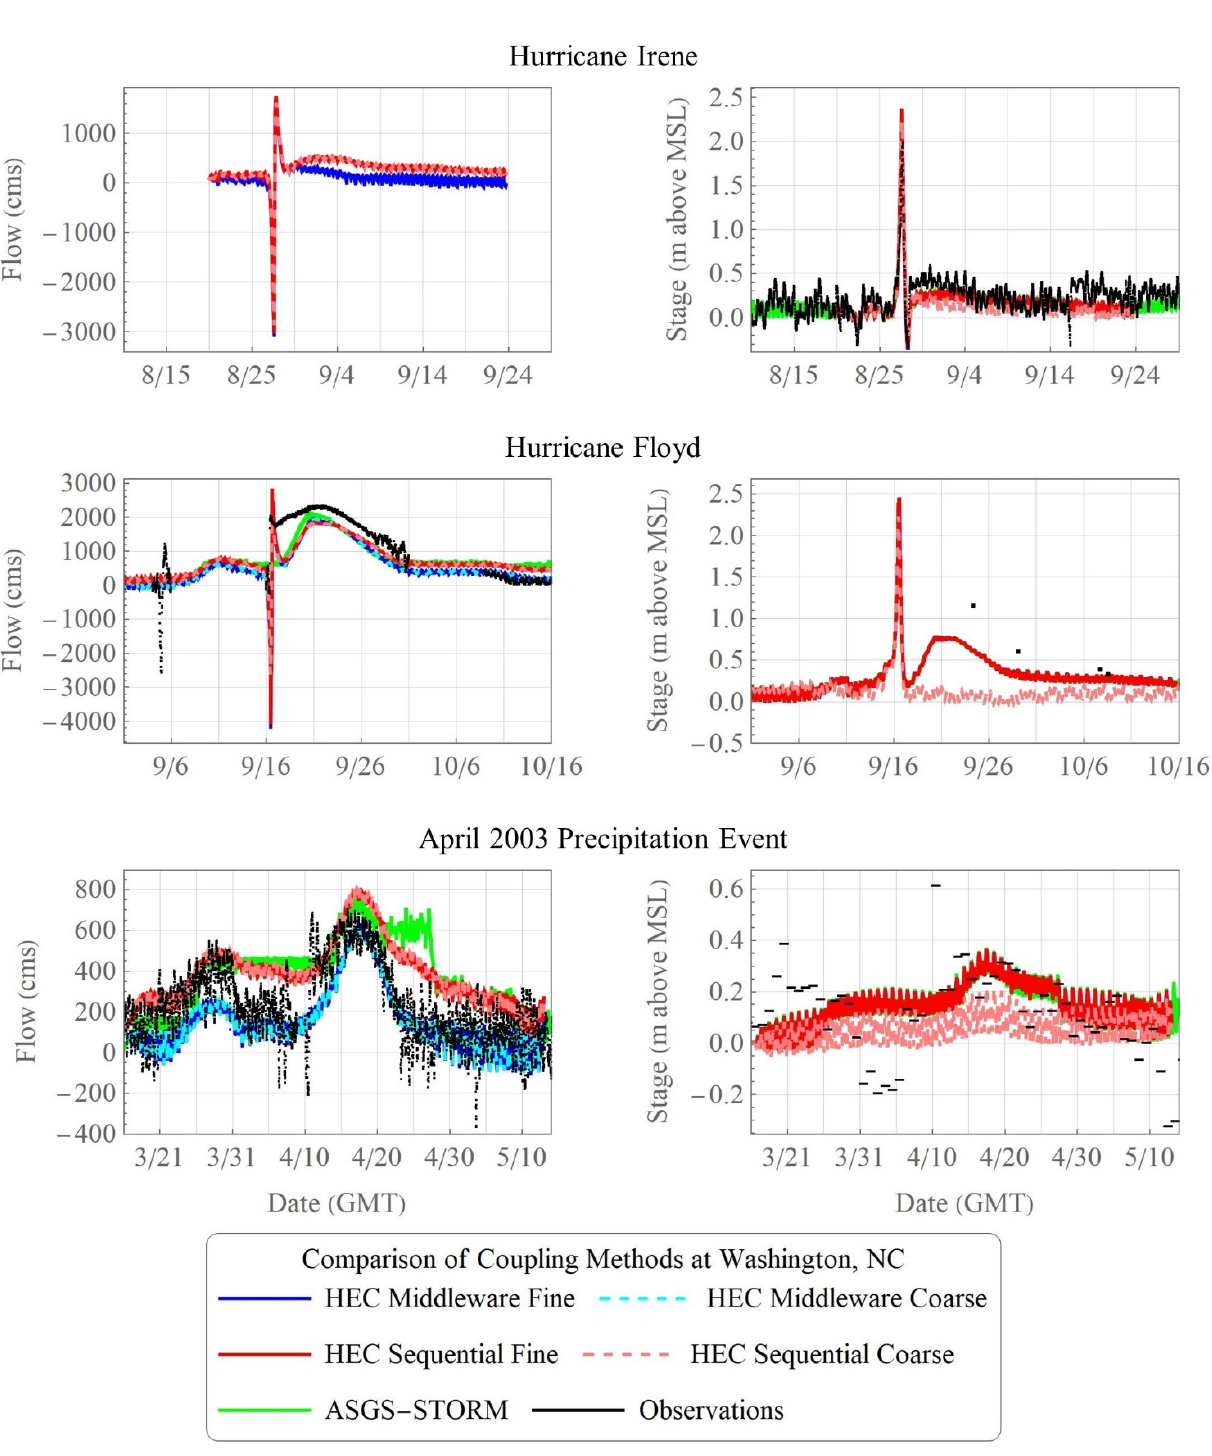
Figure 6. Comparison of modeled and observed flow and stage for the Tar (Pamlico) River at Washington.